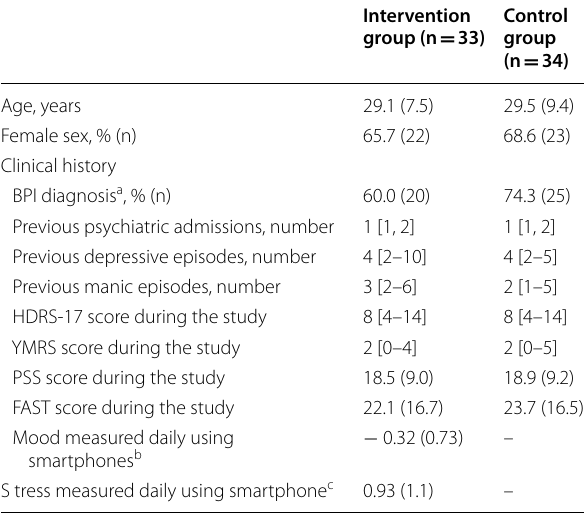
Table 1 Background characteristics and clinical information of study participants, N =